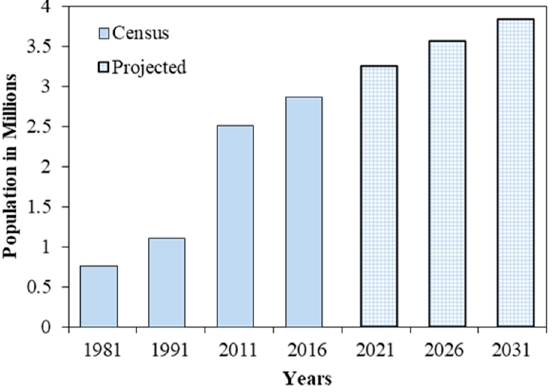
Figure A6. Population of Kathmandu Valley (includes Bhaktapur, Kathmandu, and Lalitpur) in Nepal during 1981-2031 (Source: NPHC 2011, Central Bureau of Statistics, National Planning Commission Secretarial, Government of Nepal). Table A1. Accuracy assessment report of Land Use/Land Cover classification in Kathmandu (1988– 2018).